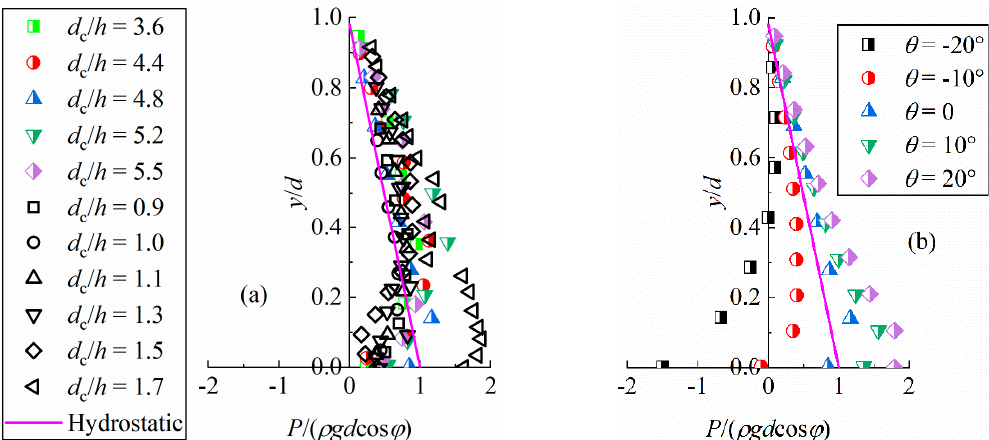
Figure 4. Pressure distributions at the step vertex (step no. 10): ( a ) θ = 0, and ( b ) d c / h = 4.8. A half-filled symbol refers to numerical results of this study, and an open one to experimental ones by Zhang and Chanson [23].